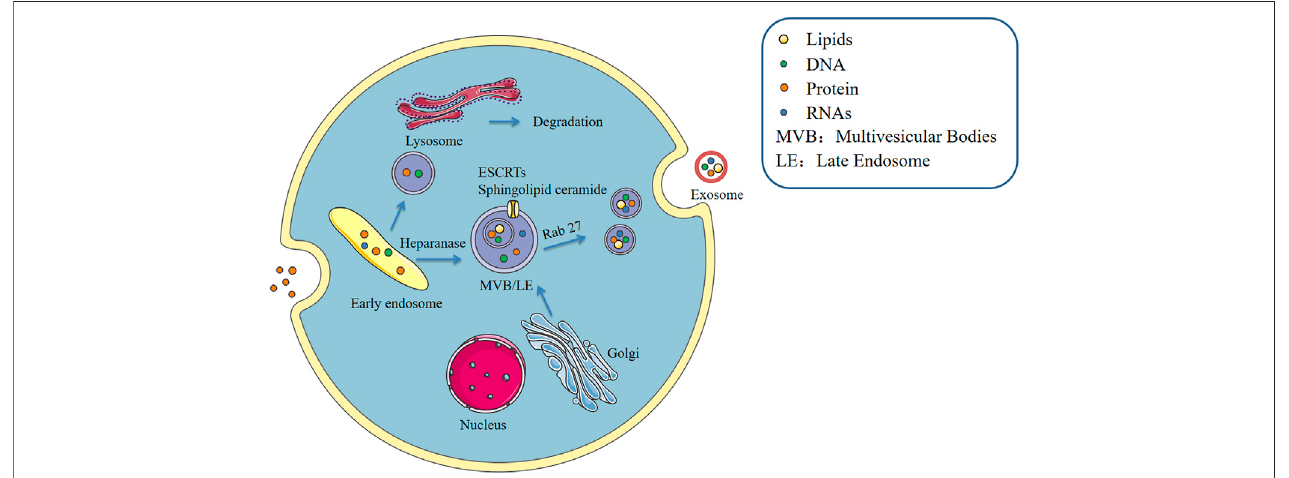
FIGURE 1 | Formation of